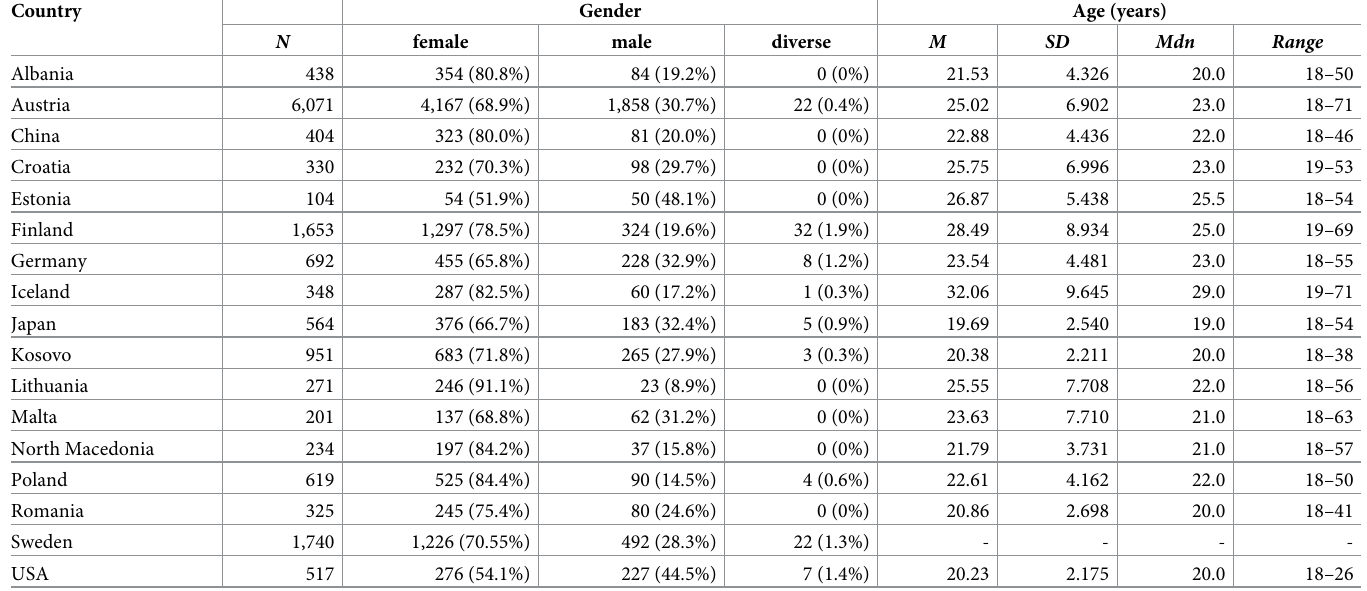
Table 1. Sociodemographic characteristics of participants per